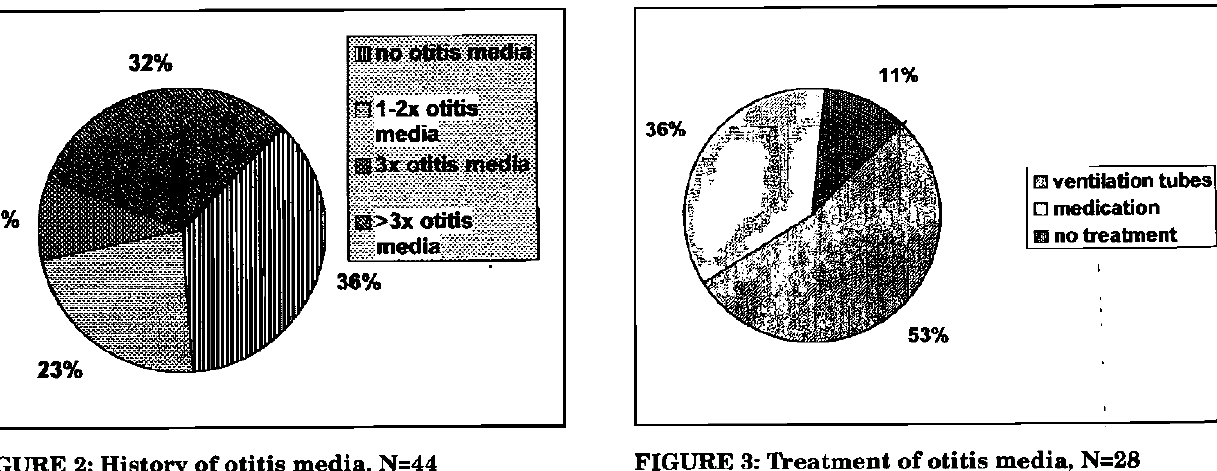
FIGURE 2: History of otitis media, N=44 FIGURE 3: Treatment of otitis media, N=28 TABLE 2. Results of Audiological Assessment,